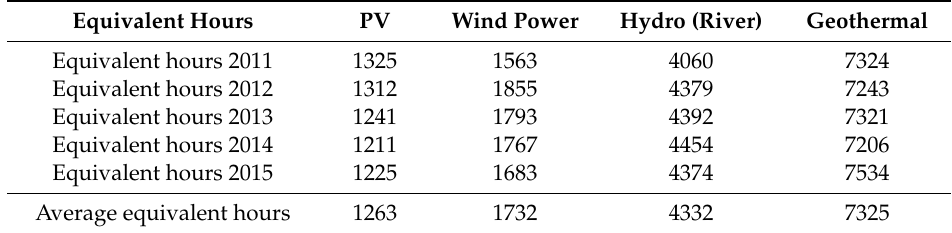
Table 2. Equivalent hours for renewable energy sources in Italy: Photovoltaic (PV), wind power, river hydro and geothermal. Values from 2011 to